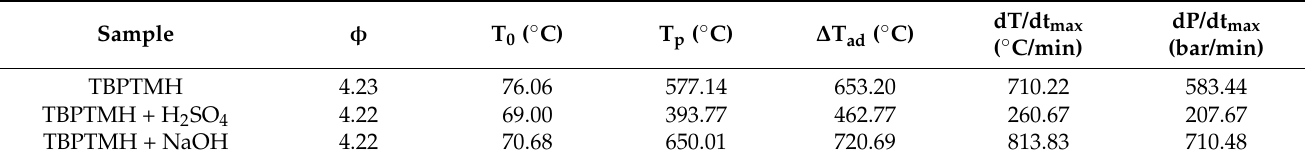
Table 5. Calculation results by Starink method. Table 6. Corrected adiabatic data of